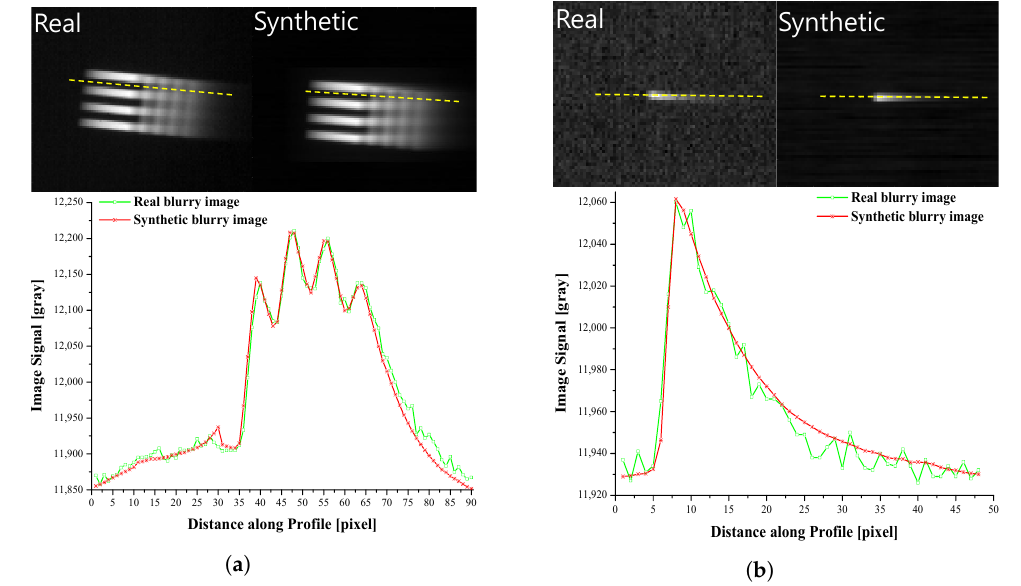
Figure 6. The comparison of real blurry images and synthetic blur images. ( a ) 4-bar pattern, ( b ) Point